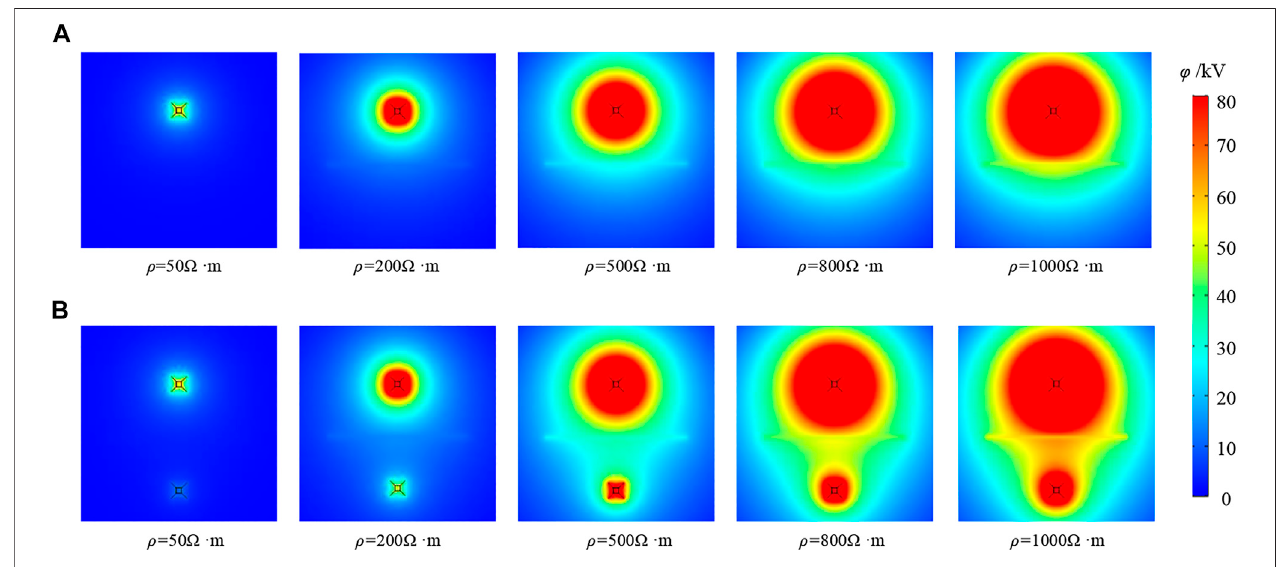
FIGURE 4 | Grounding grids, pipeline, and surrounding soil potential distribution.